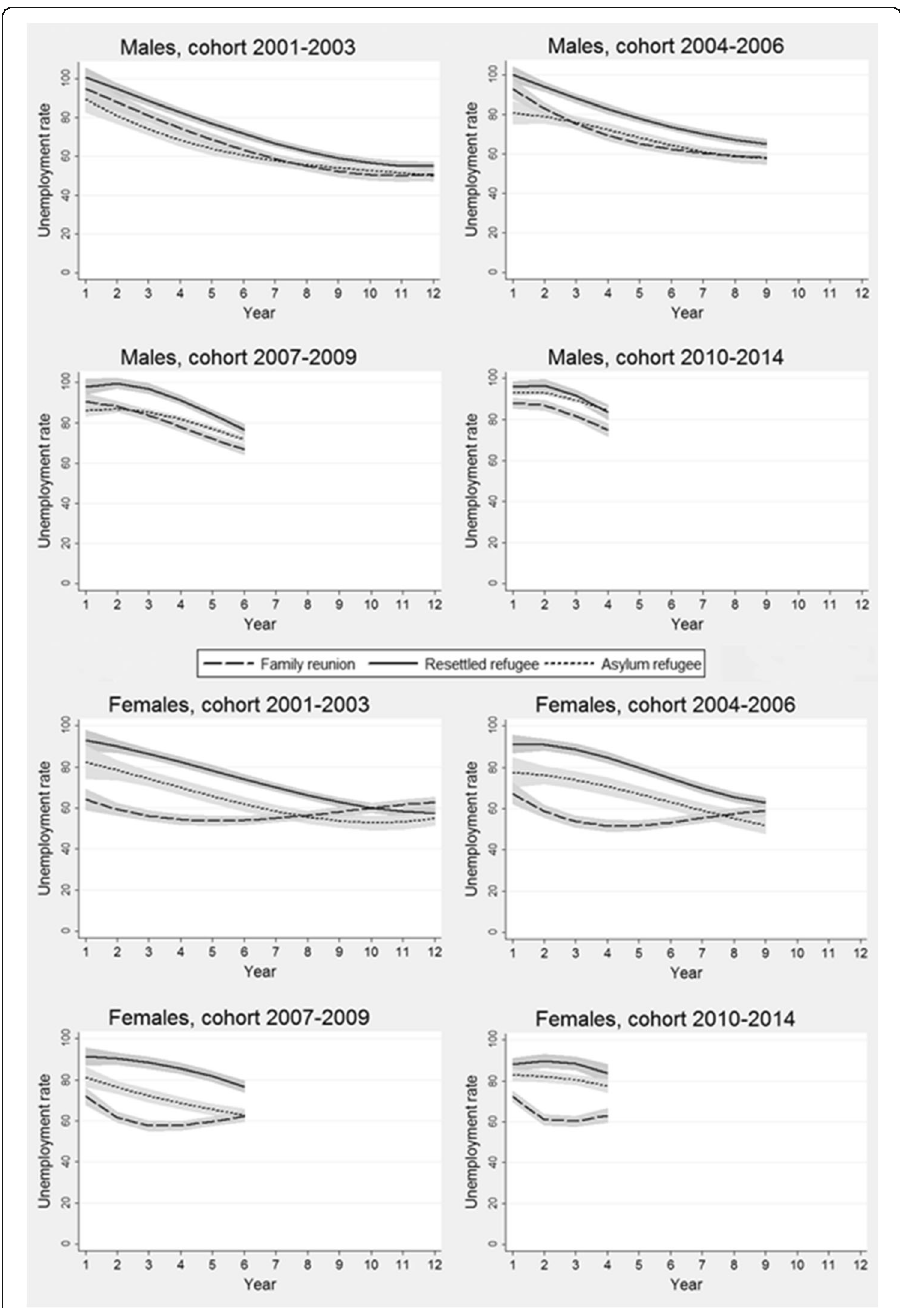
Fig. 6 The predicted unemployment rate by admission category, migration cohort and duration of stay among individuals aged 25 – 60,